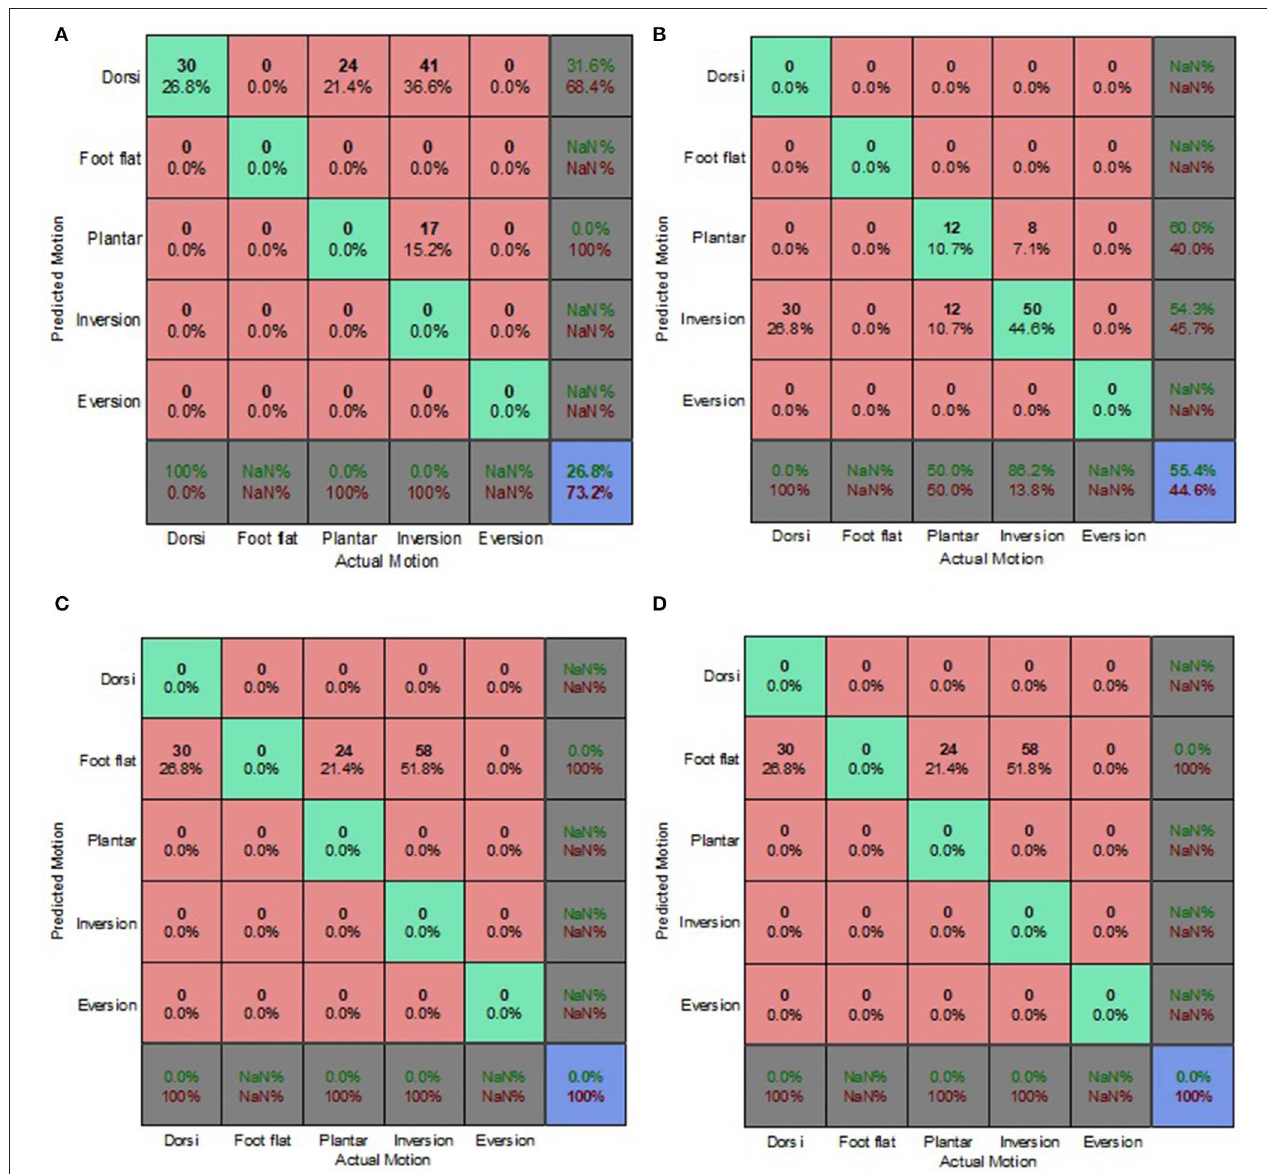
FIGURE 12 | Electrode Shift Condition Decoupled Data Set—UT Biased Generic Approach. (A) Tree, (B) LDA, (C) Deterministic, and (D) Voting scheme.